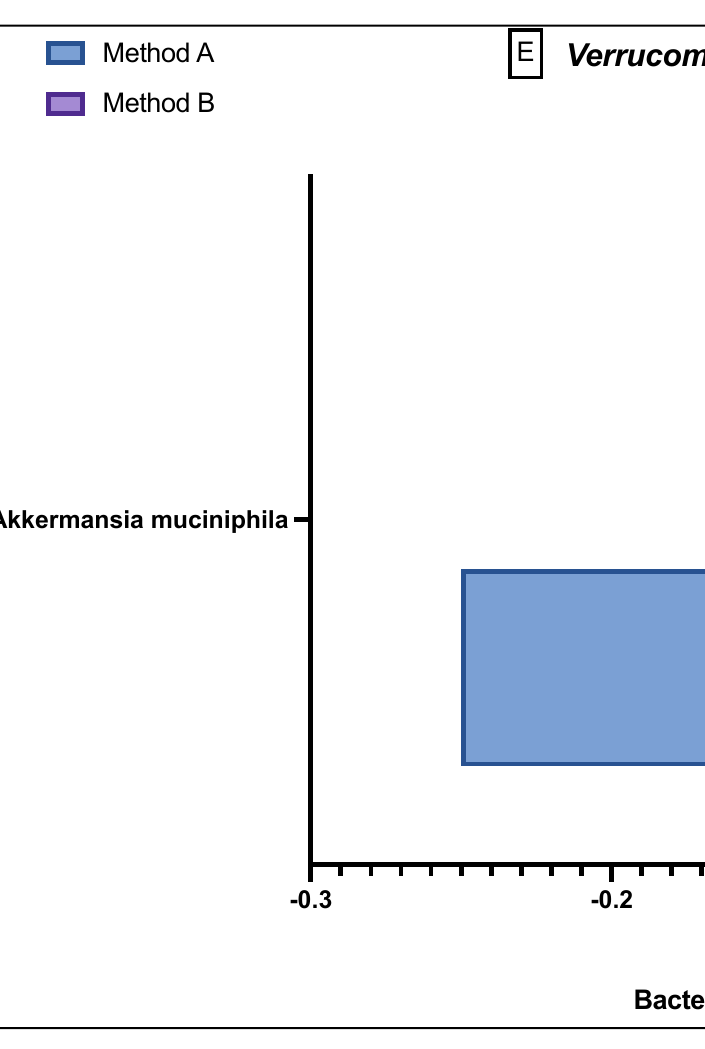
Figure 3. Comparison of bacterial abundance between method A and B samples as determined by the GA-map ® Dysbiosis test. Relative bacterial abundance is shown on a scale from ±3 in deviation from the GA-map ® normal reference range (0). Bacterial species are broken into their phyla: ( A ) Actinomycetota , ( B ) Bacteroidota , ( C ) Bacillota , ( D ) Pseudomonadota , ( E ) Verrucomicrobiota . The sixth phyla, Tenericutes , did not show any difference between the two methods and did not deviate from the normal reference range. D/M: Dialister invisus and Megasphaera micronuciformis , L/P: Lactobacillus rumminus and Pediococcus acidolactici , R/R: Ruminococcus albus and R bromii , S/E: Streptococcus agalac- tiae and Eubacterium rectale , S/S: Streptococcus salivarius ssp thermophilus and Streptococcus sanguinis,